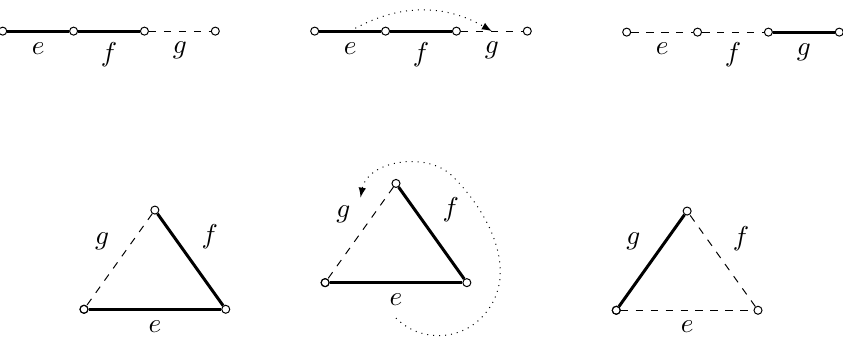
Figure 2: Possible jumps in path-stick solitaire.